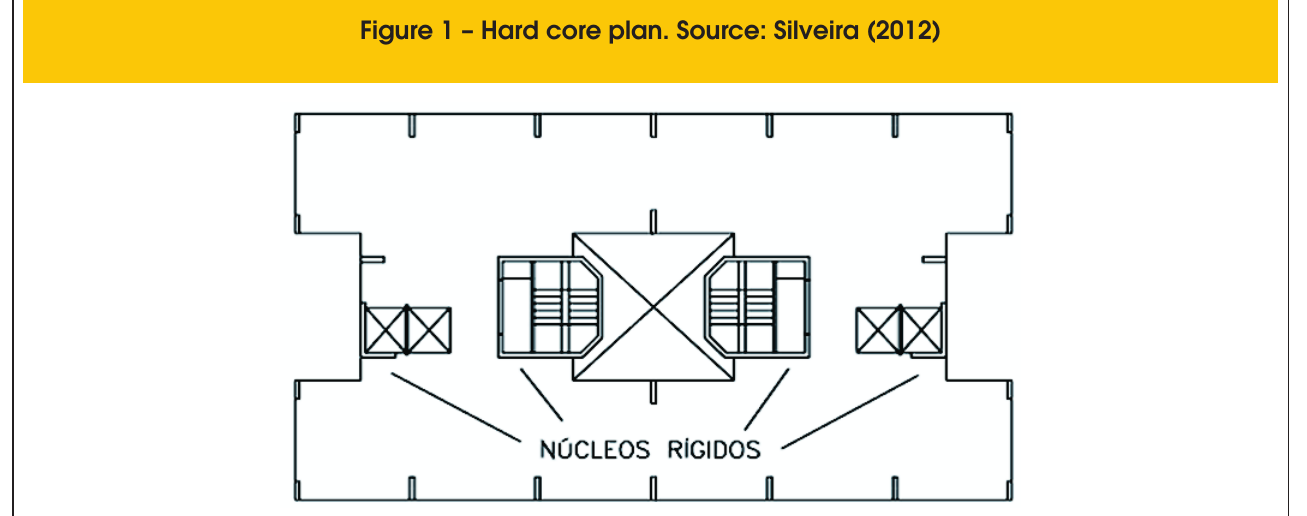
Figure 1 – Hard core plan. Source: Silveira